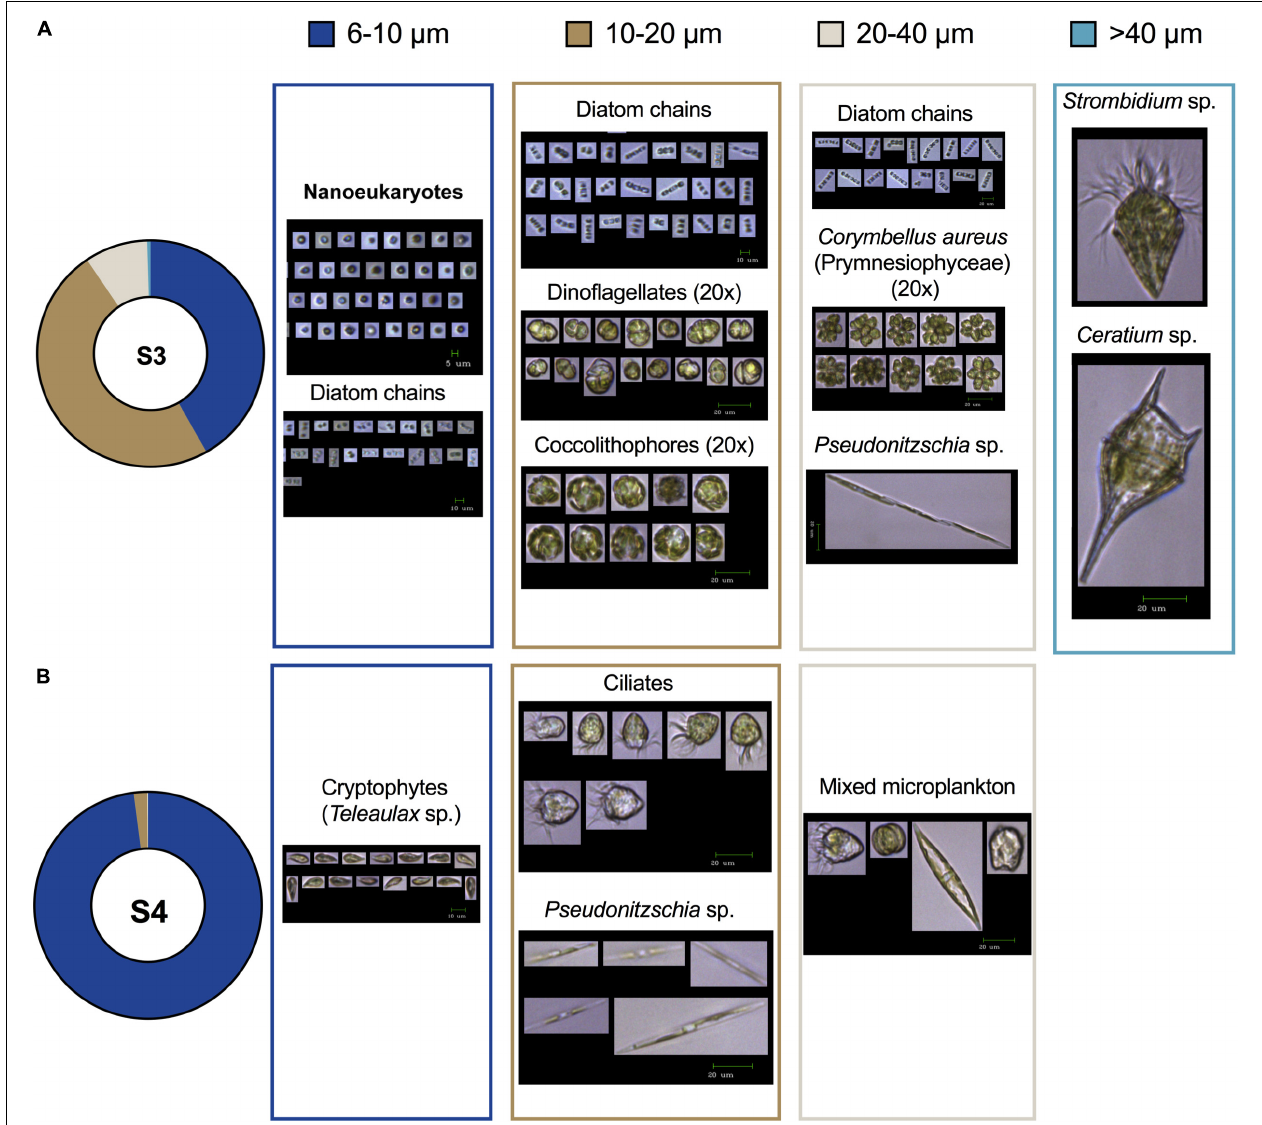
FIGURE 6 | Plankton size composition (left donuts) and image collages showing species composition of > 6 µ m plankton at Station 3 ( A , top) and Station 4 ( B , bottom) of the NAAMES May 2016 North Atlantic campaign, corresponding to the particle and size-fractionated Chl a concentrations shown in Figure 5 . Within size-class morphological diversity is easily captured with this image based approach. Note different scale bars of 10 and 20 µ m are shown for each group of